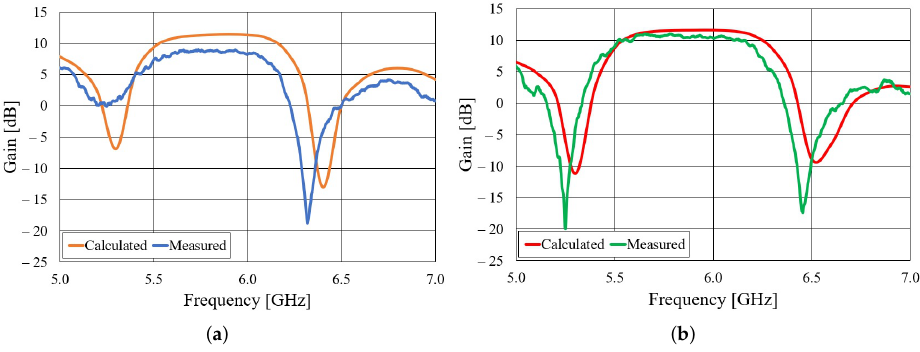
Figure 7. Realized gain of the slotted waveguide antennas: ( a ) Textile antenna, ( b ) aluminum